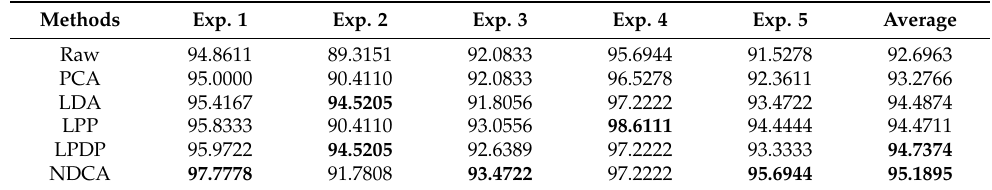
Table 8. Classification accuracy (%) of different dimension reduction algorithms using ELM as the classifier.